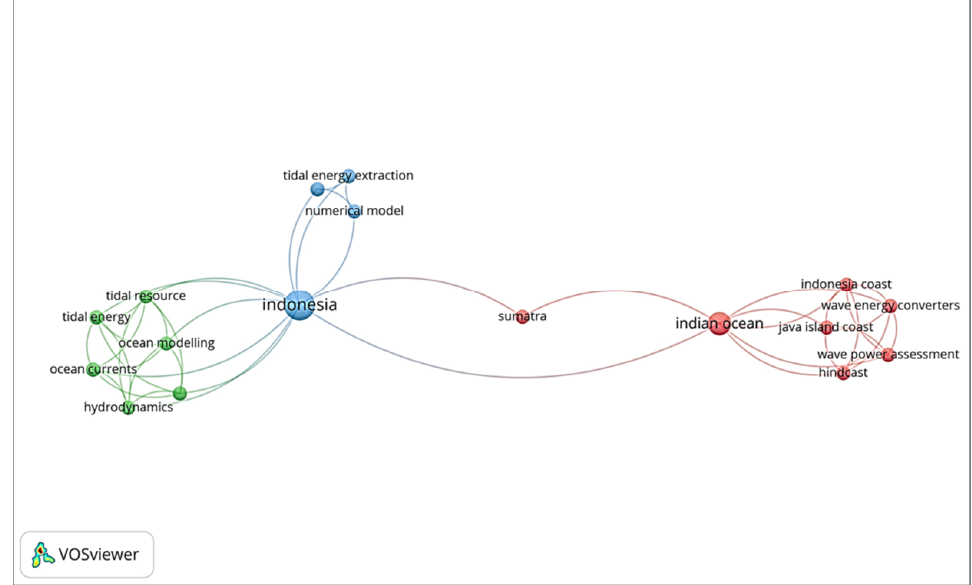
Figure 3. Keyword co-occurrence map based on bibliographic data of publications from 2000 to 2020 in the field of MRE in Indonesian waters (see Supplementary Materials for details of the analysis).